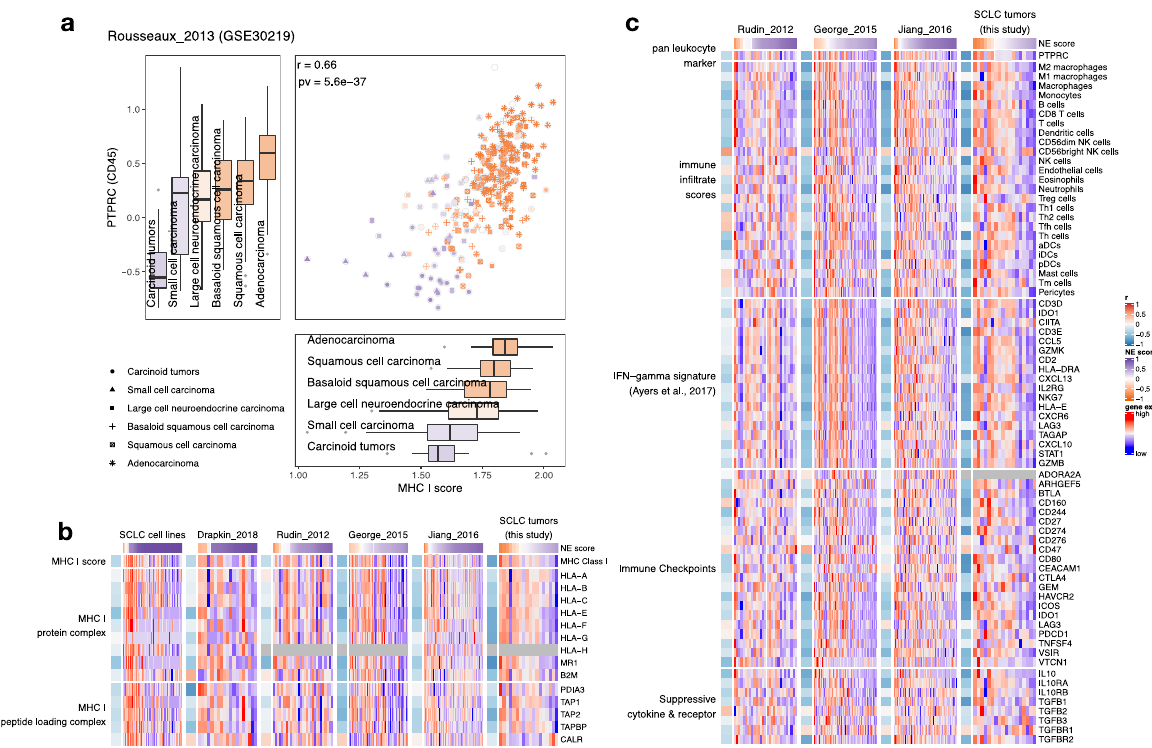
Fig. 3 Low NE-score variant SCLC has increased tumor – immune interaction. a Expression of MHC I genes and pan-leukocyte marker PTPRC in lung tumors from the “ Rousseaux_2013 ” data set. Box whisker plots are fi lled with color re fl ecting the median NE score in different histological subtypes. The centerline in the boxplot represents the median, the lower and upper hinges correspond to the fi rst and third quartiles, the whiskers extend from the hinge to the value no further than 1.5 * IQR away. Color for scatterplot symbols re fl ects NE score for different samples. b Heatmaps visualizing expression of MHC I genes across multiple SCLC data sets. c Heatmaps visualizing expression of PTPRC , immune-cell-type-speci fi c signature scores, PD-1 blockade response-predicting IFN-gamma-related signature genes 49 , immune checkpoint genes, and suppressive cytokines and receptors in SCLC tumor data sets. MHC I score and immune in fi ltrate scores were computed using ssGSEA methodology. Sample-wise z -score standardized values were used for the